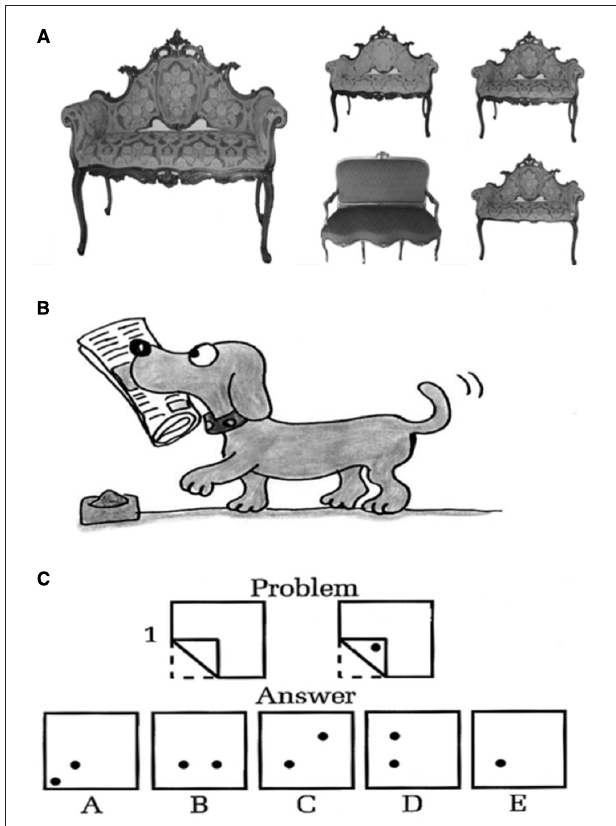
FIGURE 2 | (A) Generation Task: Example of item of the Object task: target (on the left), response option (on the right). (B) Inspection Task: Example of item of the Object Inspection Task. (C) Transformation Task: Example of item of the Paper Folding Task. The figures “Problem” represent a square piece of paper being folded, and the last of these figures has one or two small circles drawn on it to show where the paper has been punched. Each hole is punched through all the thicknesses of paper at that point. The five figures “Answer” show where the holes will be when the paper is completely